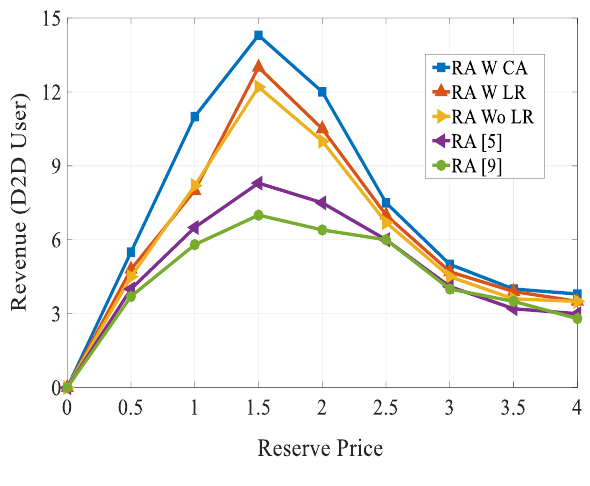
Figure 12. Revenue vs. reserve price.